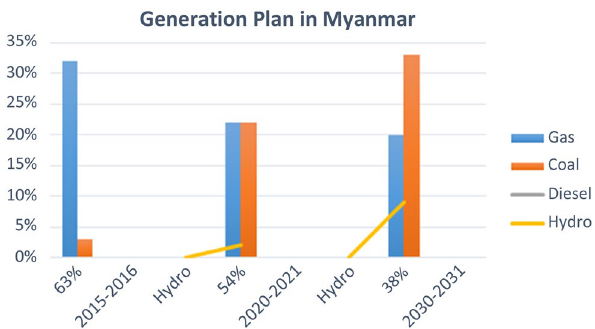
Fig. 2 Generation plan in